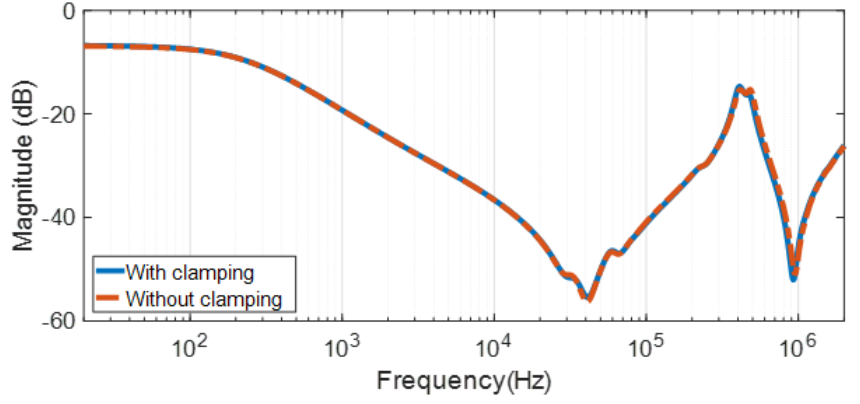
Figure 5. End-to-end short circuit test on HV winding. Measurement at terminals R-Y for phase R.